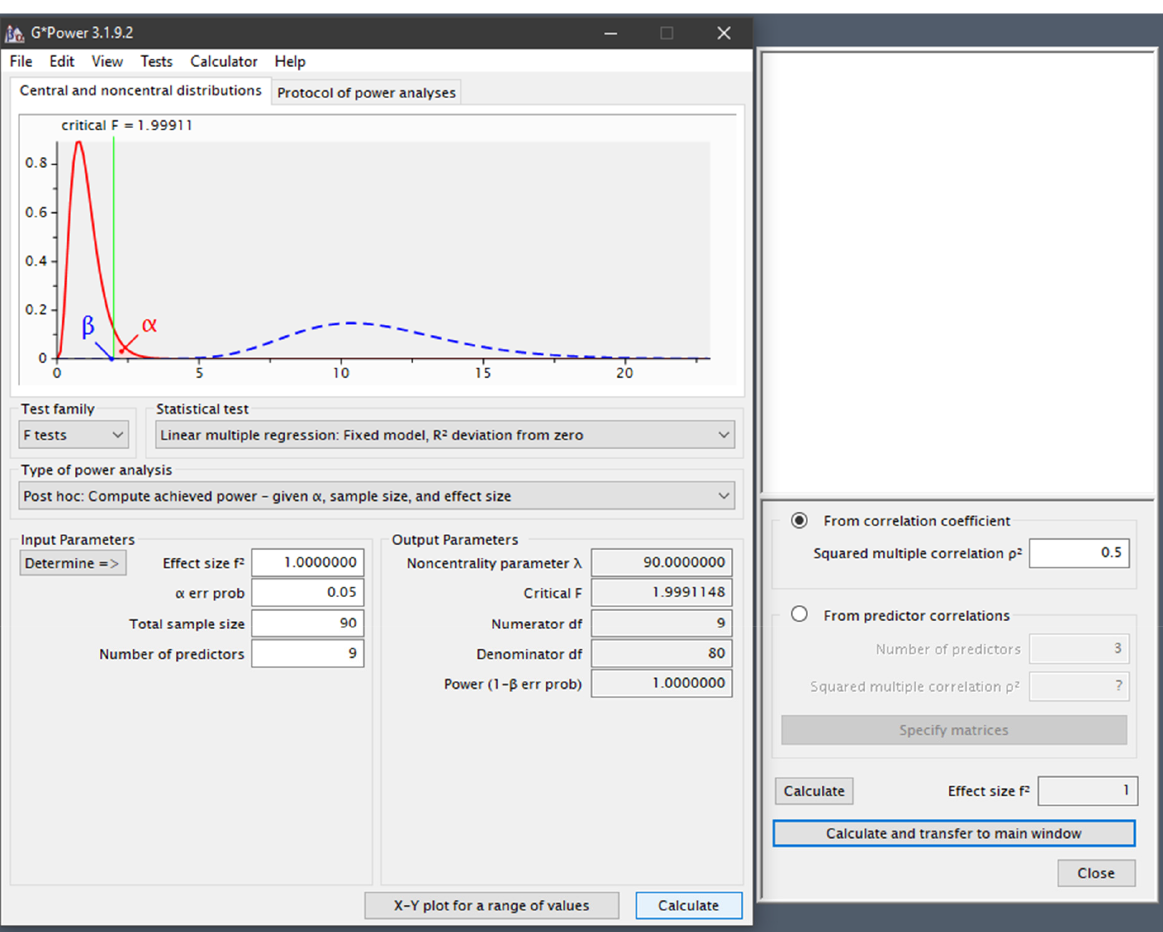
Figure 8. Procedure to calculate statistical power with G*power